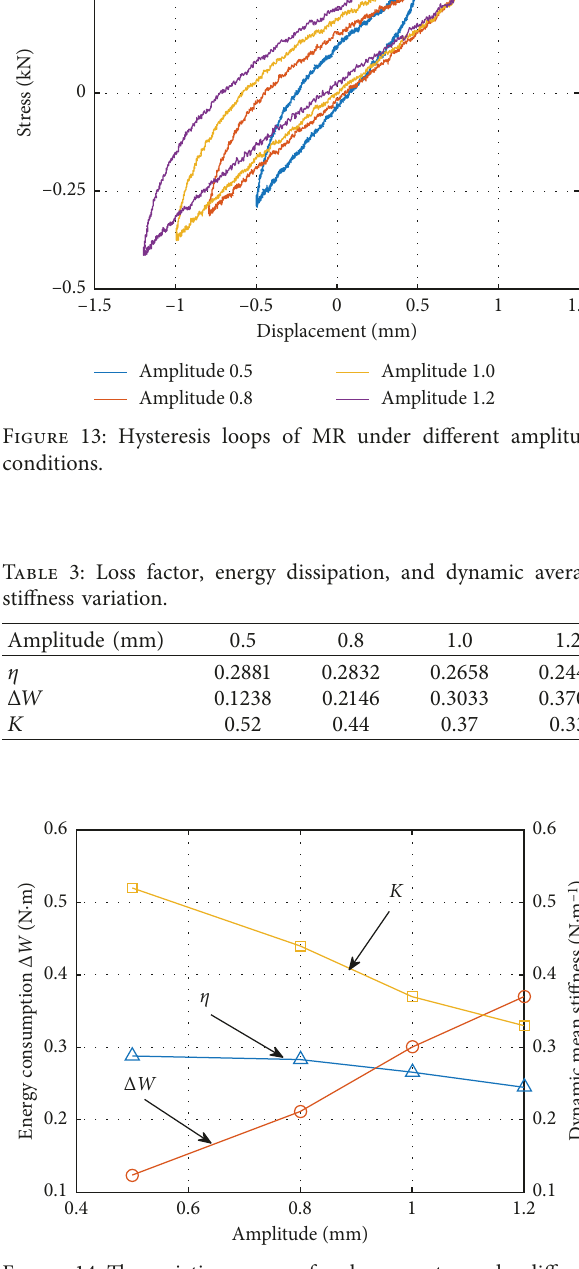
Figure 14: The variation curves of each parameter under different amplitudes. η is the dissipation factor.